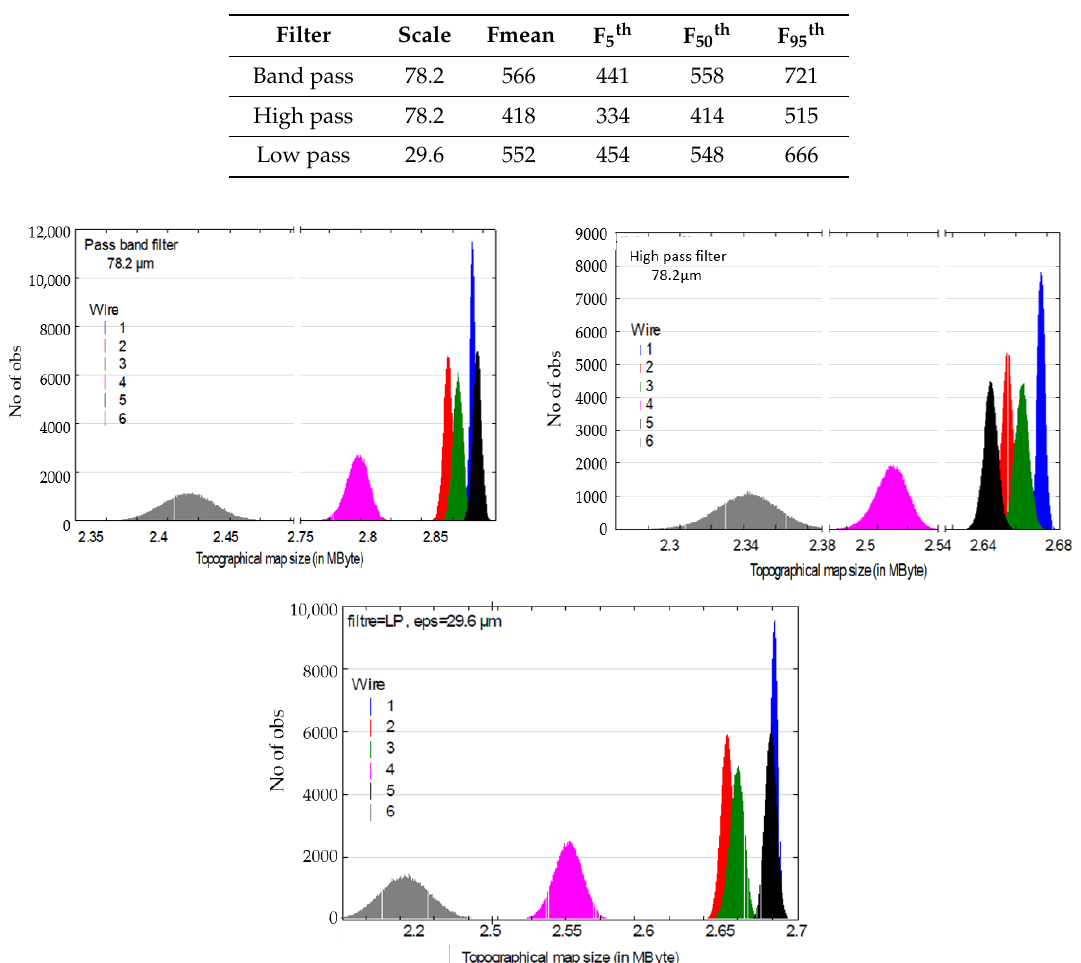
Figure 10 . Histograms of size (mean) of the compressed image at the maximal scales of relevance. Figure 10. Histograms of size (mean) of the compressed image at the maximal scales of